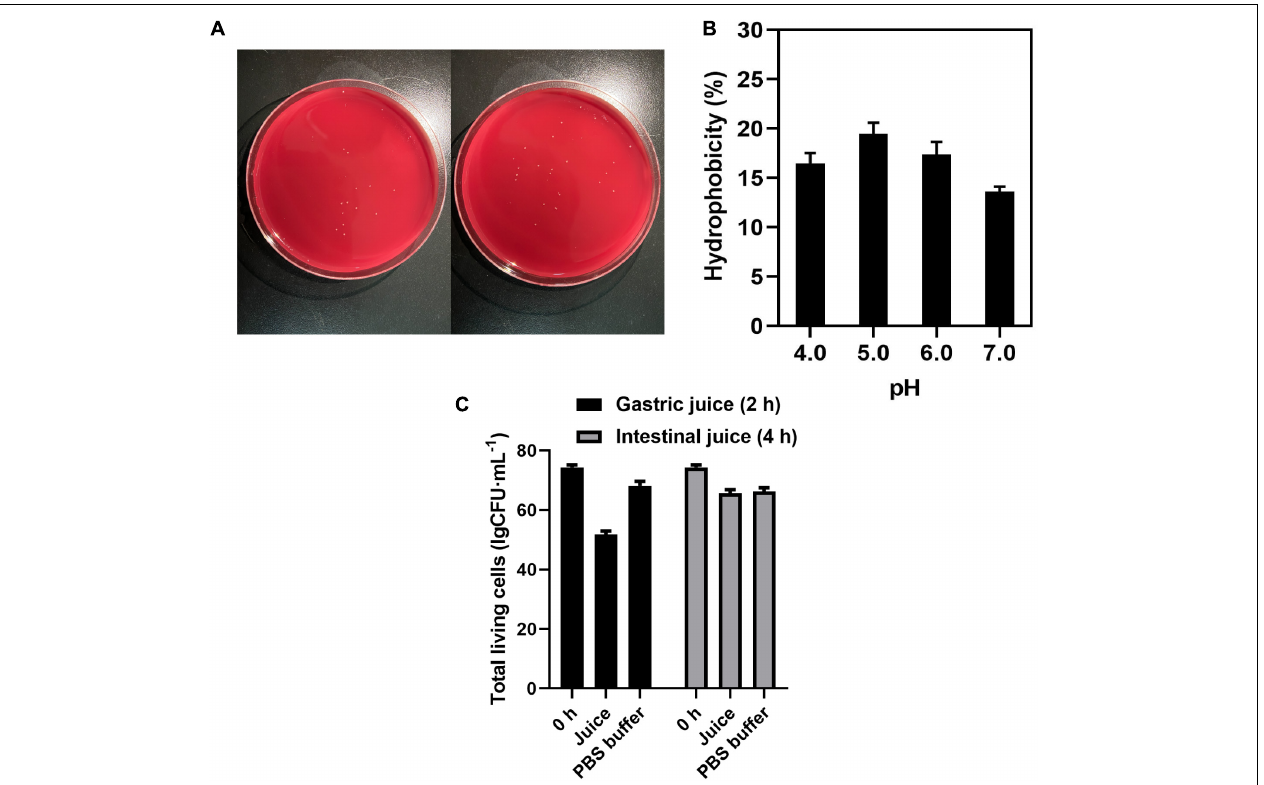
FIGURE 2 | (A) Hemolysis of C. tyrobutyricum L319 on blood plate. (B) Hydrophobicity assay of C. tyrobutyricum L319 at pH 4.0, 5.0, 6.0, and 7.0. (C) The total living cells survive in the gastric juice and intestinal juice. Controls all refer to the strains suspended in PBS.